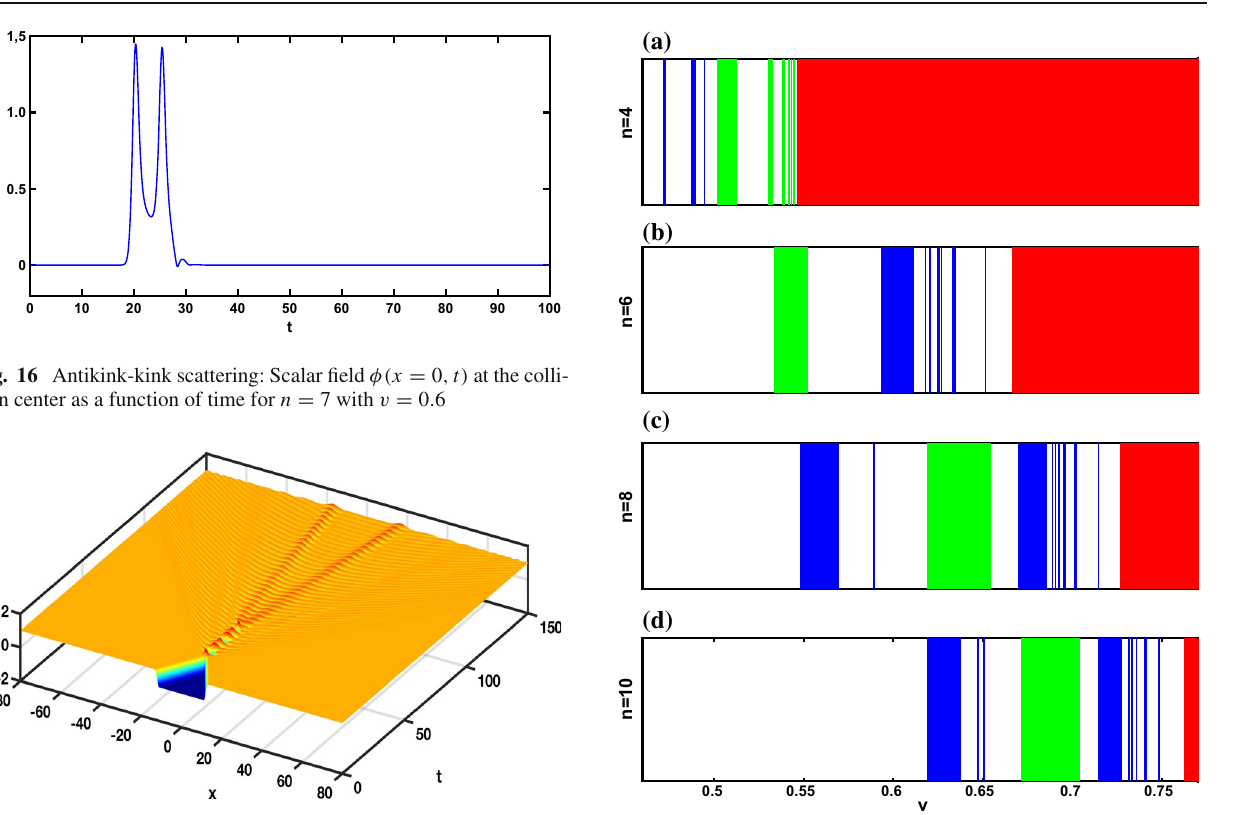
kink-antikink collision, since for larger values of n , the left and right tails of the composed structure engender the com- pact profile. As we have shown, the difference appears as very distinct outcomes of the two collisions, and the results may be of current physical interest. As we have shown in Eq. (6), the tail of the compact portion of the solution has a very short double exponential range, which acts to modify